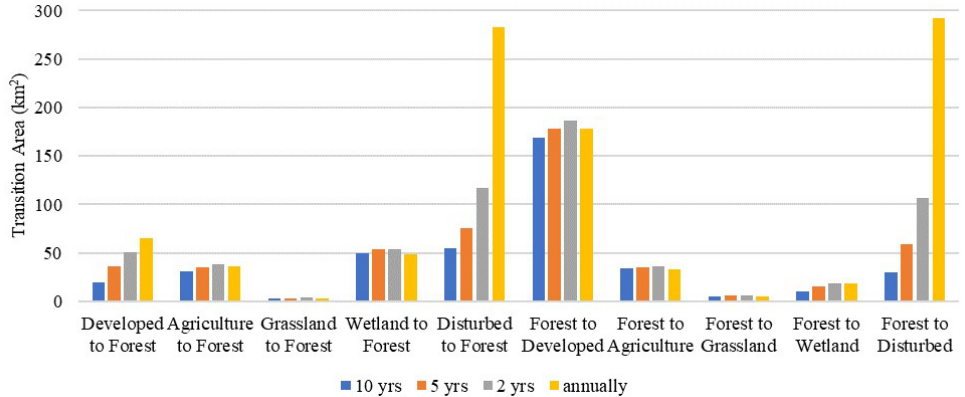
Figure 8. Geographic comparison of land transition area resulting from various time intervals. (a), (b), (c), and (d) are the sum of forest increase resulting from respective scenarios of 10 yrs, 5 yrs, 2 yrs, and annual. (e), (f), (g) and (h) are the sum of forest decrease resulting from respective scenarios of 10 yrs, 5 yrs, 2 yrs, and annual.